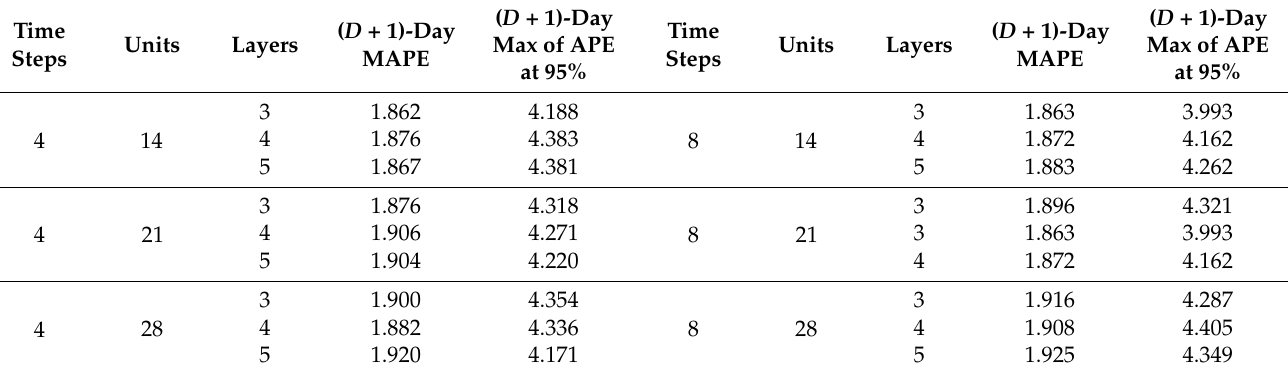
Table 1. Performance accuracy of various RNN